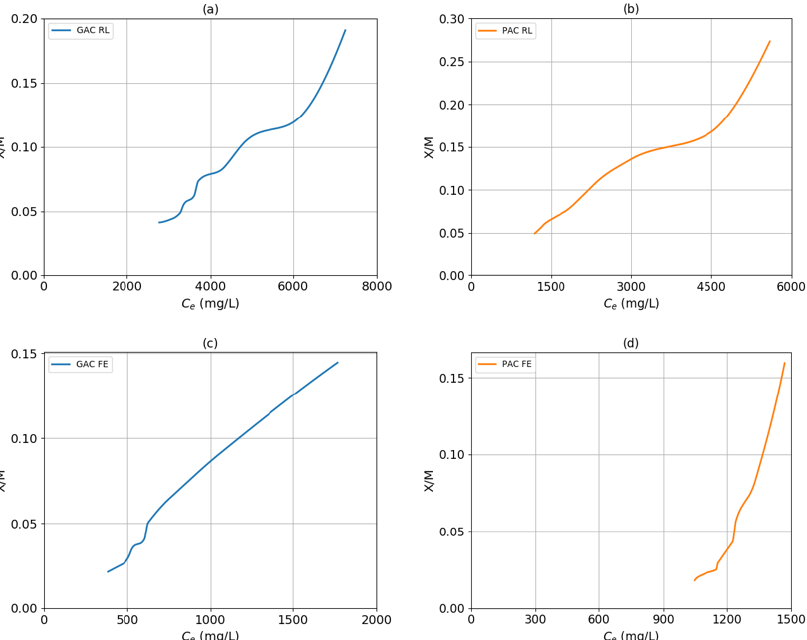
Figure 2. Experimental isotherms: granular activated carbon with raw leachate (GAC RL) (a) , powdered activated carbon with raw leachate (PAC RL) (b) , granular activated carbon with Fenton effluent (GAC FE) (c) and powdered activated carbon with Fenton effluent (PAC FE) (d) .